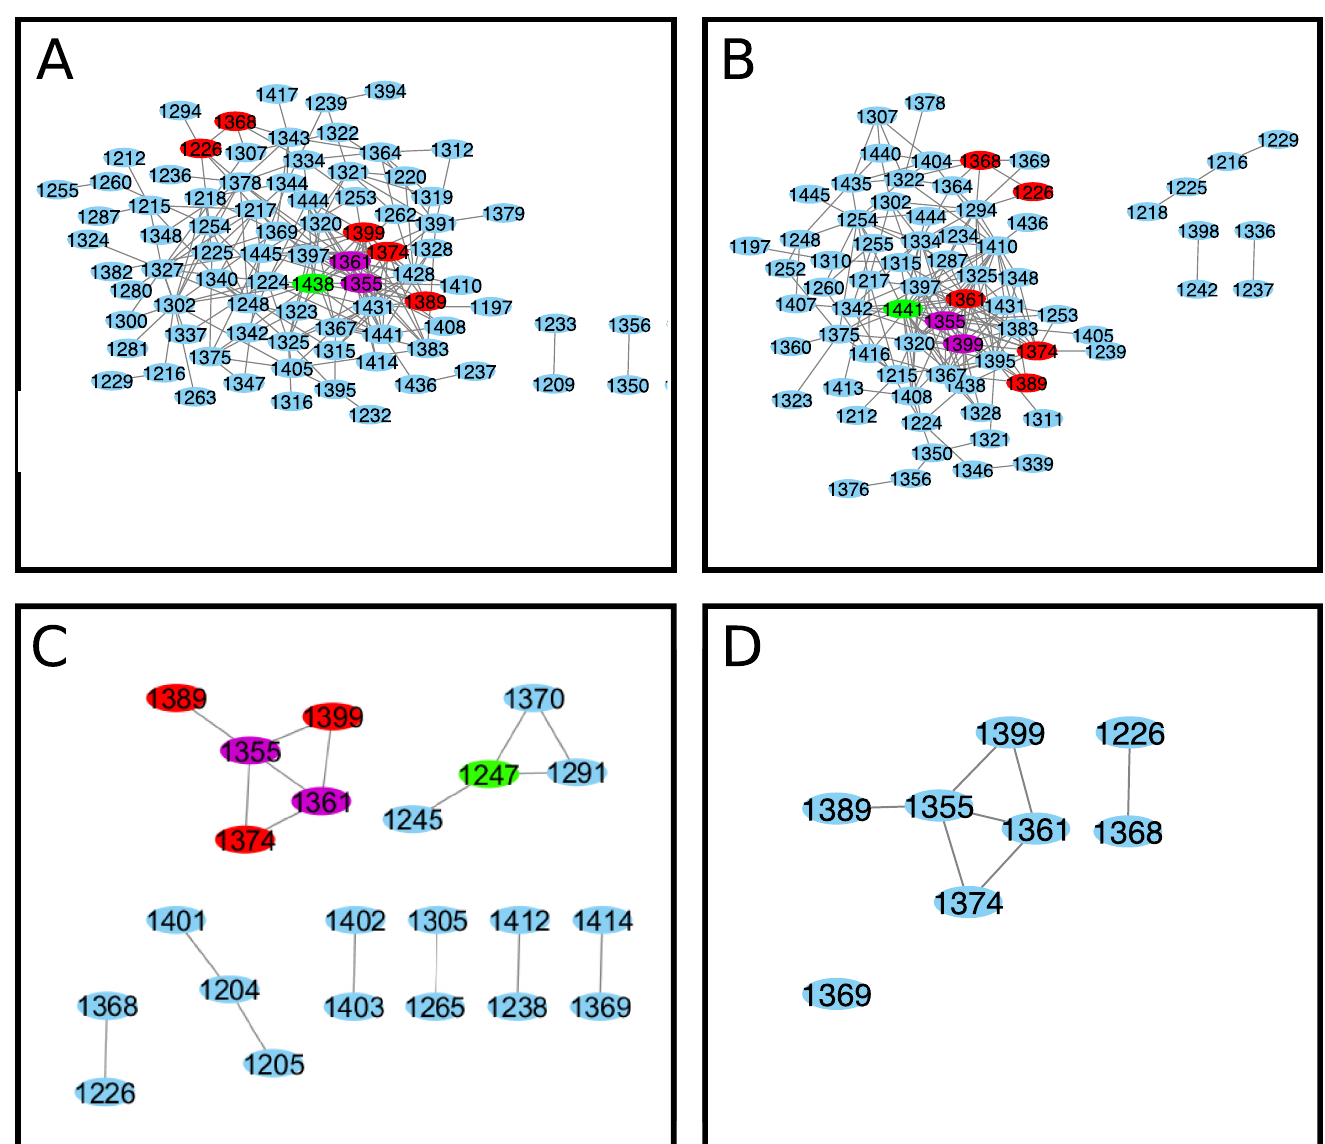
Fig 5. NBD2 cytoscape interaction map for S1235R perturbation analysis. (A) ELSC (S1235R) coupling matrix (B) OMES (S1235R) coupling matrix (C) McBASC (S1235R) coupling matrix (D) Composite of ELSC, OMES, and McBASC (S1235R) analyses. Composite map was generated from the individual maps using the top 200 coupled positions that were common to all analyses (ELSC, OMES, McBASC) using Cytoscape software. Nodes that are central and overlap in all analysis are colored purple. Nodes that overlap in all analysis are colored red, and central nodes are colored green.